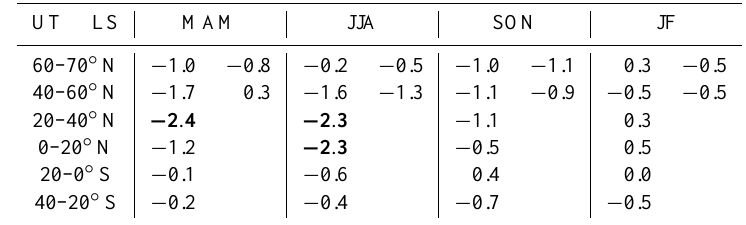
Table 2. Bias values of GOSAT/TANSO-FTS TIR V1 CO 2 data against CONTRAIL (AK) CO 2 data for each season and each latitude region in the upper troposphere and lower stratosphere in units of parts per million (ppm). Significant bias values larger than ± 2ppm are indicated by